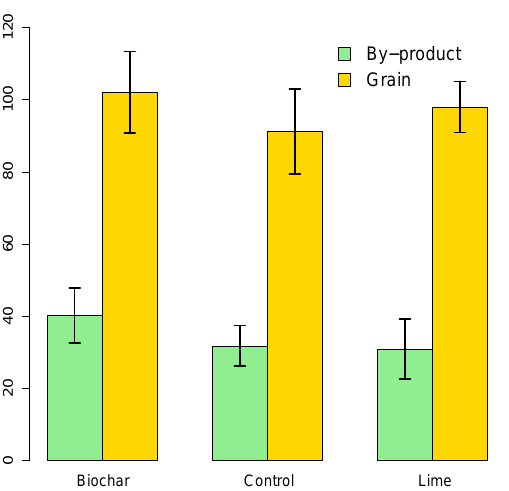
Figure 5. Grain yield and by-product biomass production (dry mat- ter yield). Error bars show 1 SE ( n = 3). Figure 6. N uptake by grains and by-product (stem, leaves). Error bars show 1 SE ( n =